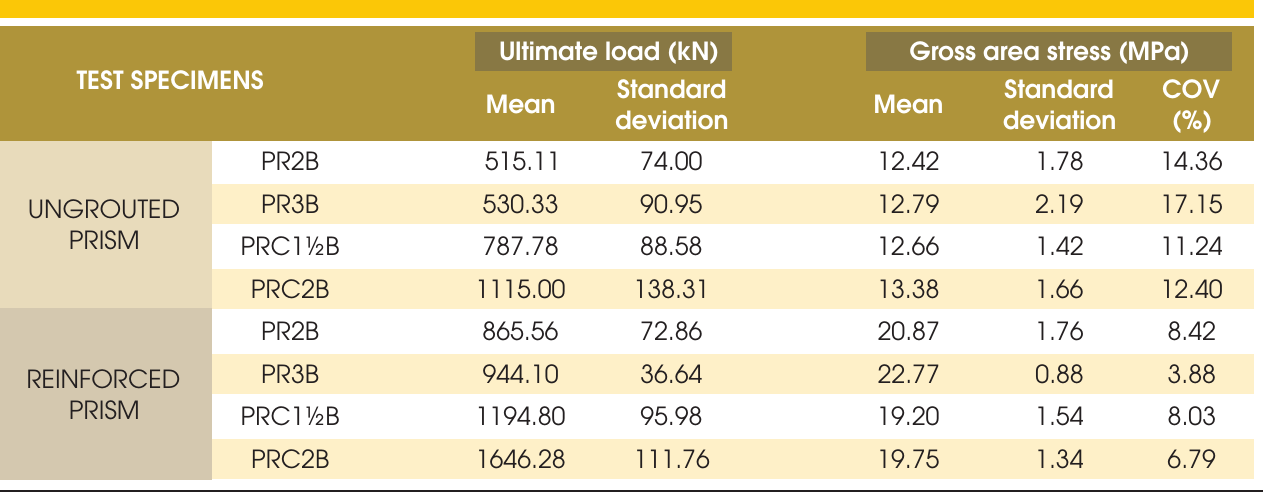
Table 4 – Axial compression test of the